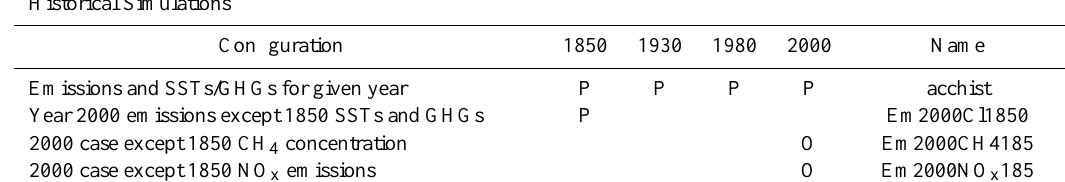
Table 1. List and principal characteristics of ACCMIP simulations. Additional simulations (1890, 1910, 1950, 1970, and 1990) were proposed as Optional and are removed from this table for clarity. SSTs stands for sea surface temperatures and GHGs for greenhouse gases. Historical Simulations Configuration Emissions and SSTs/GHGs for given